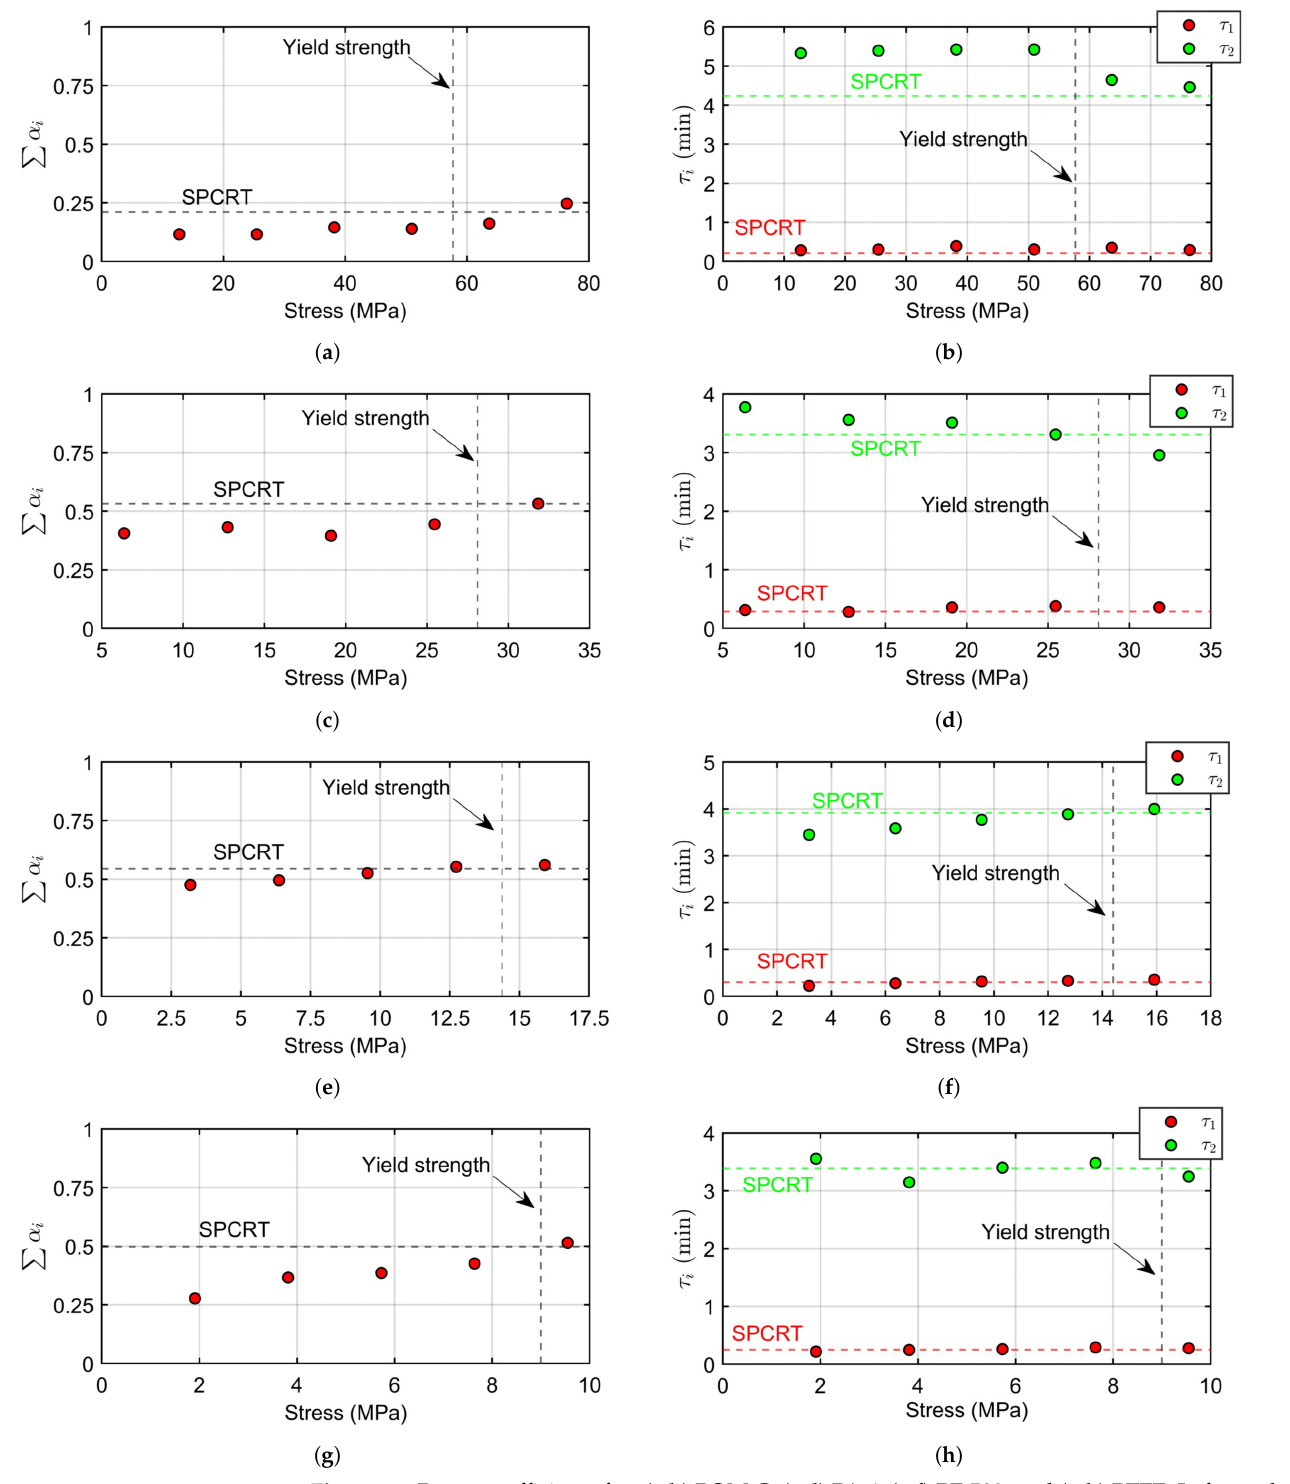
Figure 11. Prony coefficients for: ( a , b ) POM C, ( c , d ) PA 6, ( e , f ) PE 500, and ( g , h ) PTFE. Left graphs show the sum of relative modulus α i , and right graphs show relaxation times τ i